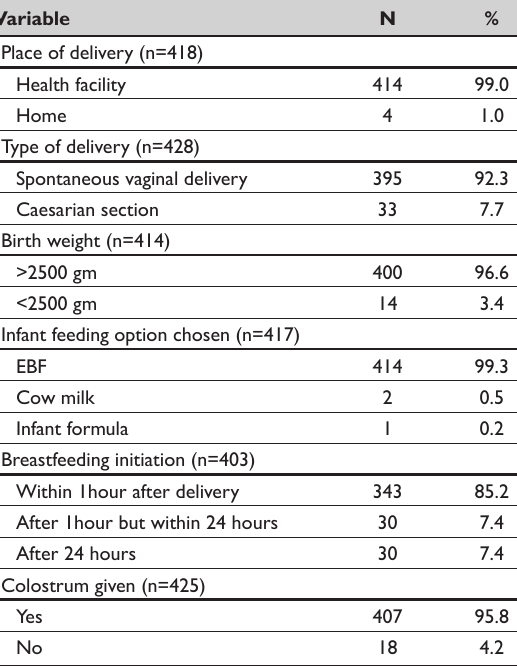
Table 2: Delivery information of 431 women who